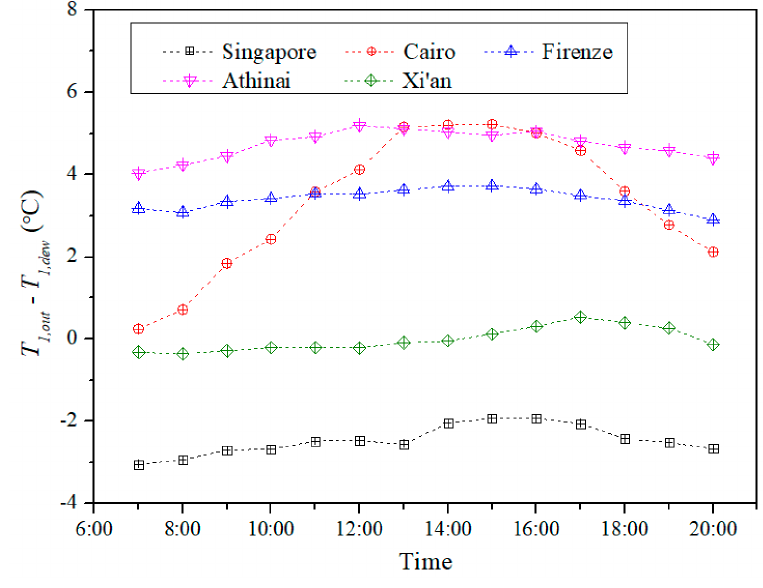
Figure 9. Comparison between the outlet air temperature and the inlet dew point temperature.